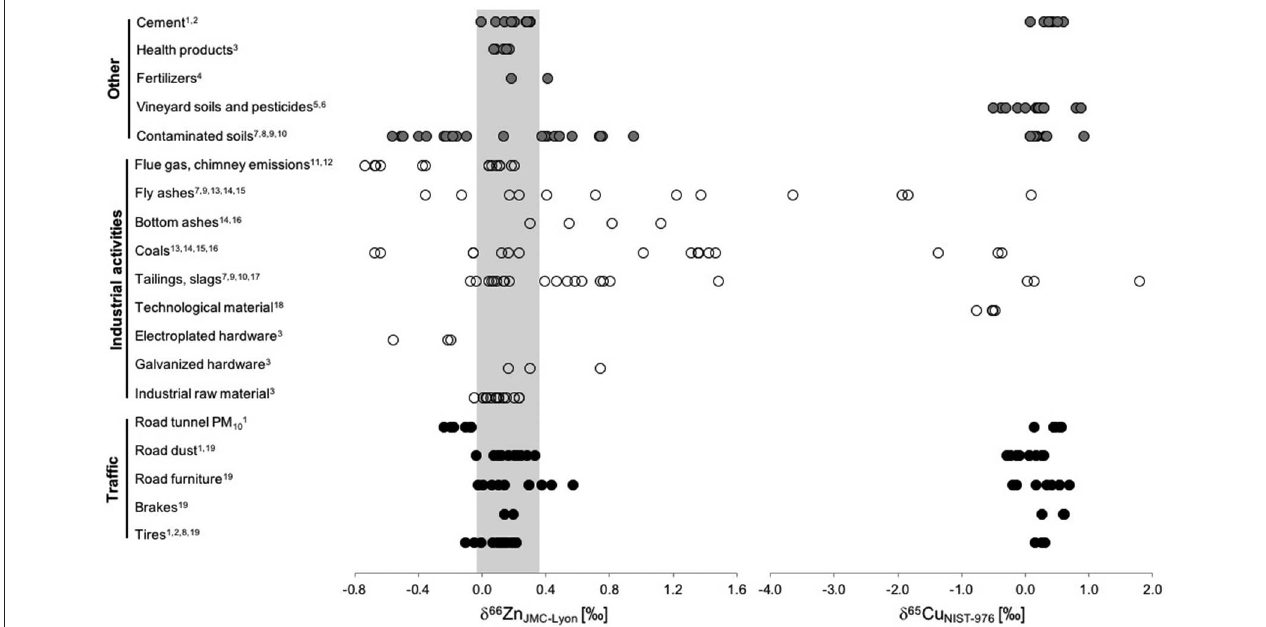
FIGURE 6 | Comparison of measured isotope ratios of Zn (left panel, expressed as δ 66 Zn JMC − Lyon ) and Cu (right panel, expressed as δ 65 Cu NIST − 976 ) in anthropogenic reservoirs (traffic: filled circles, industrial processes: open circles, other: gray circles). The gray area gives the range of natural sphalerites proposed by Sonke et al. (2008) (References: 1. Souto-Oliveira et al., 2018, 2. Souto-Oliveira et al., 2019, 3. John et al., 2007, 4. Chen et al., 2008, 5. Petit et al., 2013, 6. Blotevogel et al., 2018, 7. Sivry et al., 2008, 8. Thapalia et al., 2010, 9. Bigalke et al., 2010, 10. Juillot et al., 2011, 11. Cloquet et al., 2006, 12. Mattielli et al., 2009, 13. Novak et al., 2016, 14. Ochoa Gonzalez and Weiss, 2015, 15. Voldrichova et al., 2014, 16. Borrok et al., 2010, 17. Gelly et al., 2019, 18. Mihaljeviˇc et al., 2018, 19. Dong et al., 2017).